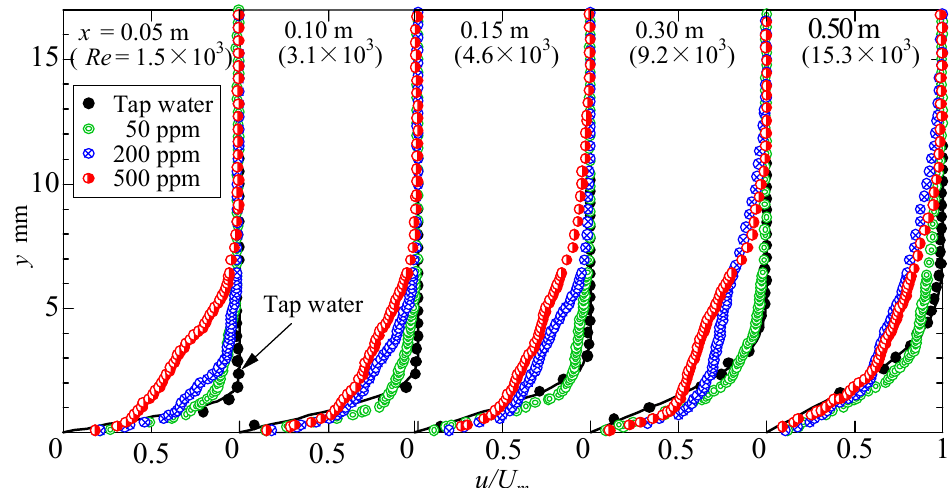
Fig. 3 Development of velocity profile for surfactant solution from the leading